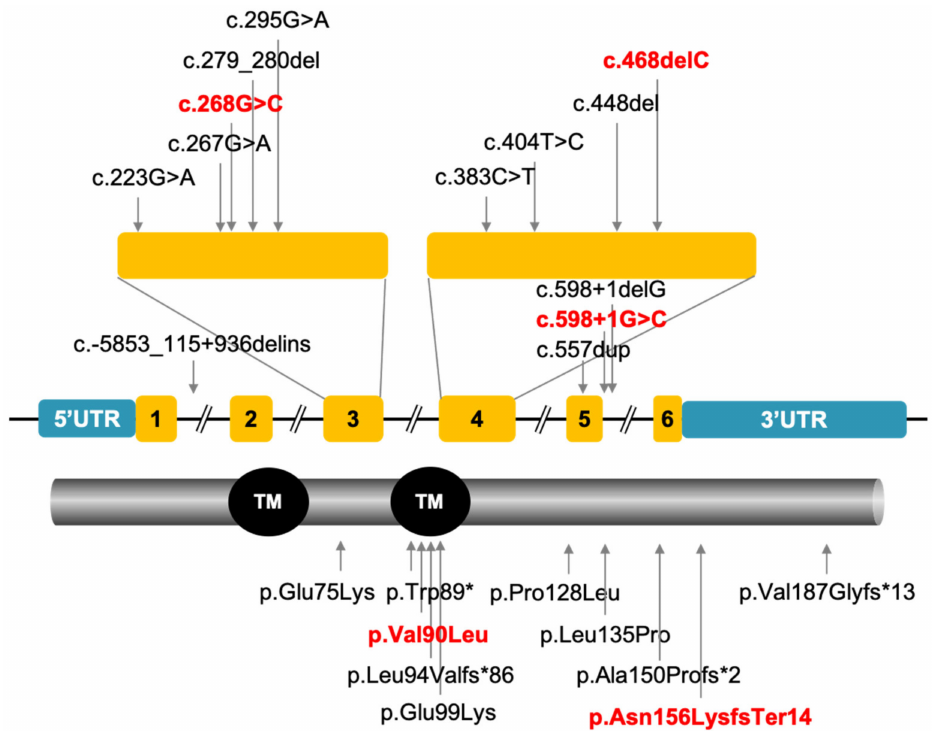
Figure 8. Ten variants in REEP6 leading to RP have been reported. The novel variants found in this study are shown in